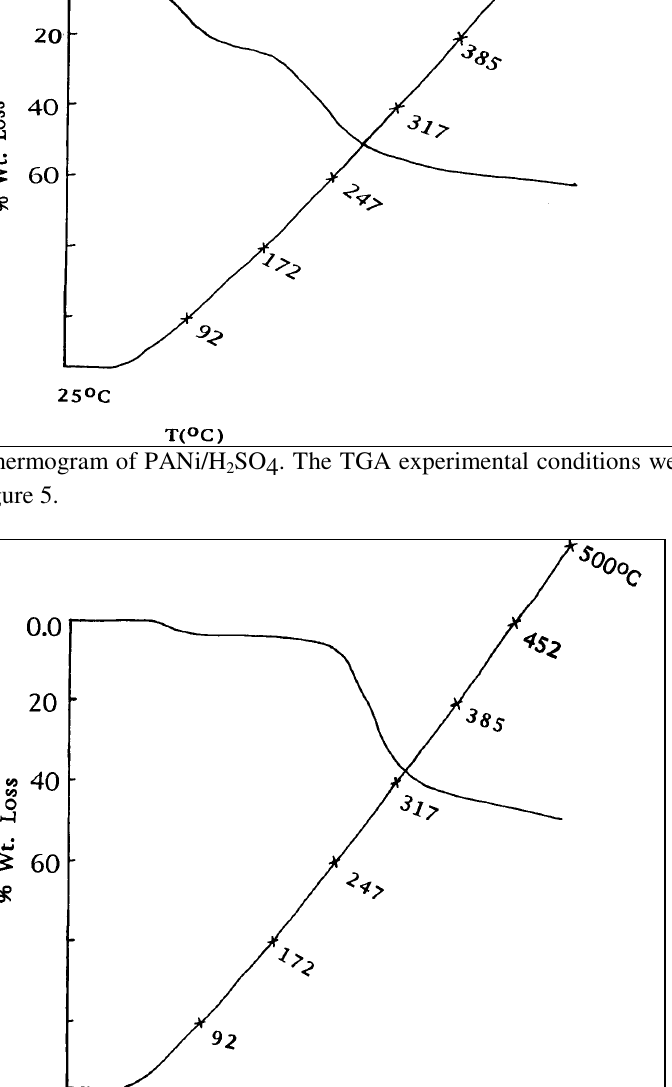
Figure 8. Thermogram of PANi/HPTS. The TGA experimental conditions were the same as used in Figure